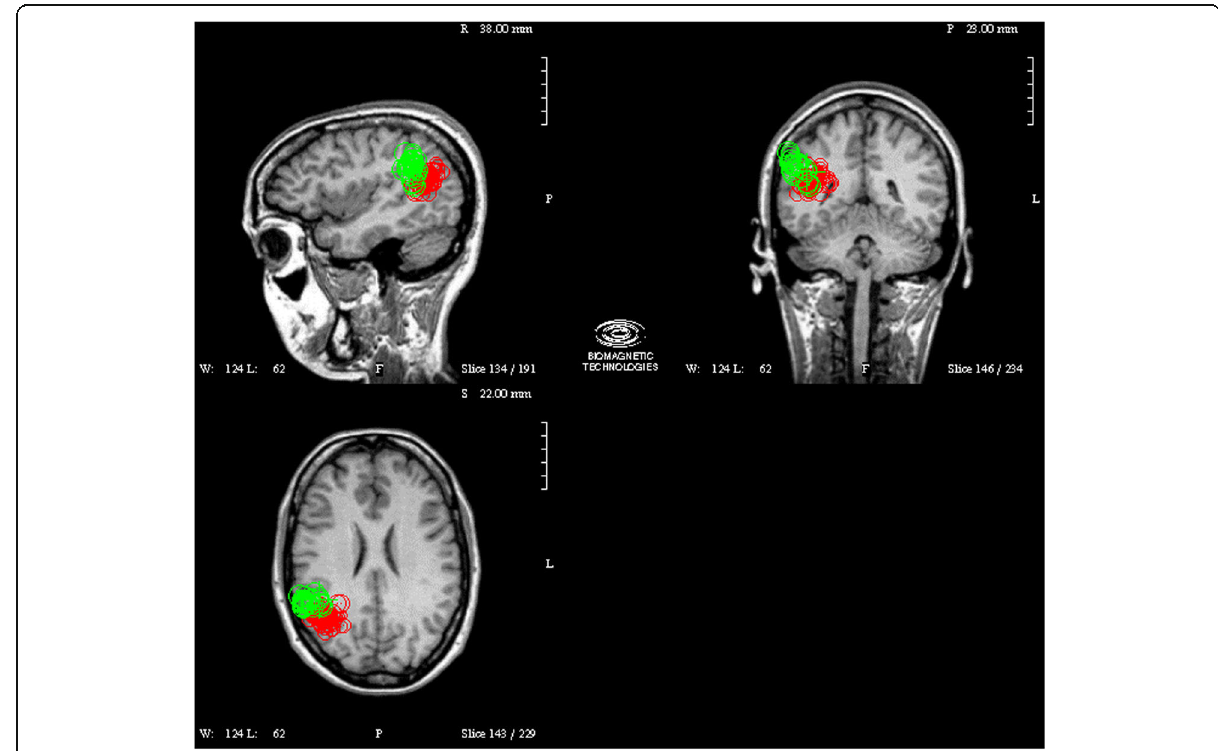
Fig. 2 Interictal and ictal magnetic source imaging (MSI) localizations in a patient with parietal focal cortical dysplasia (FCD) 2 (green: ictal, red: